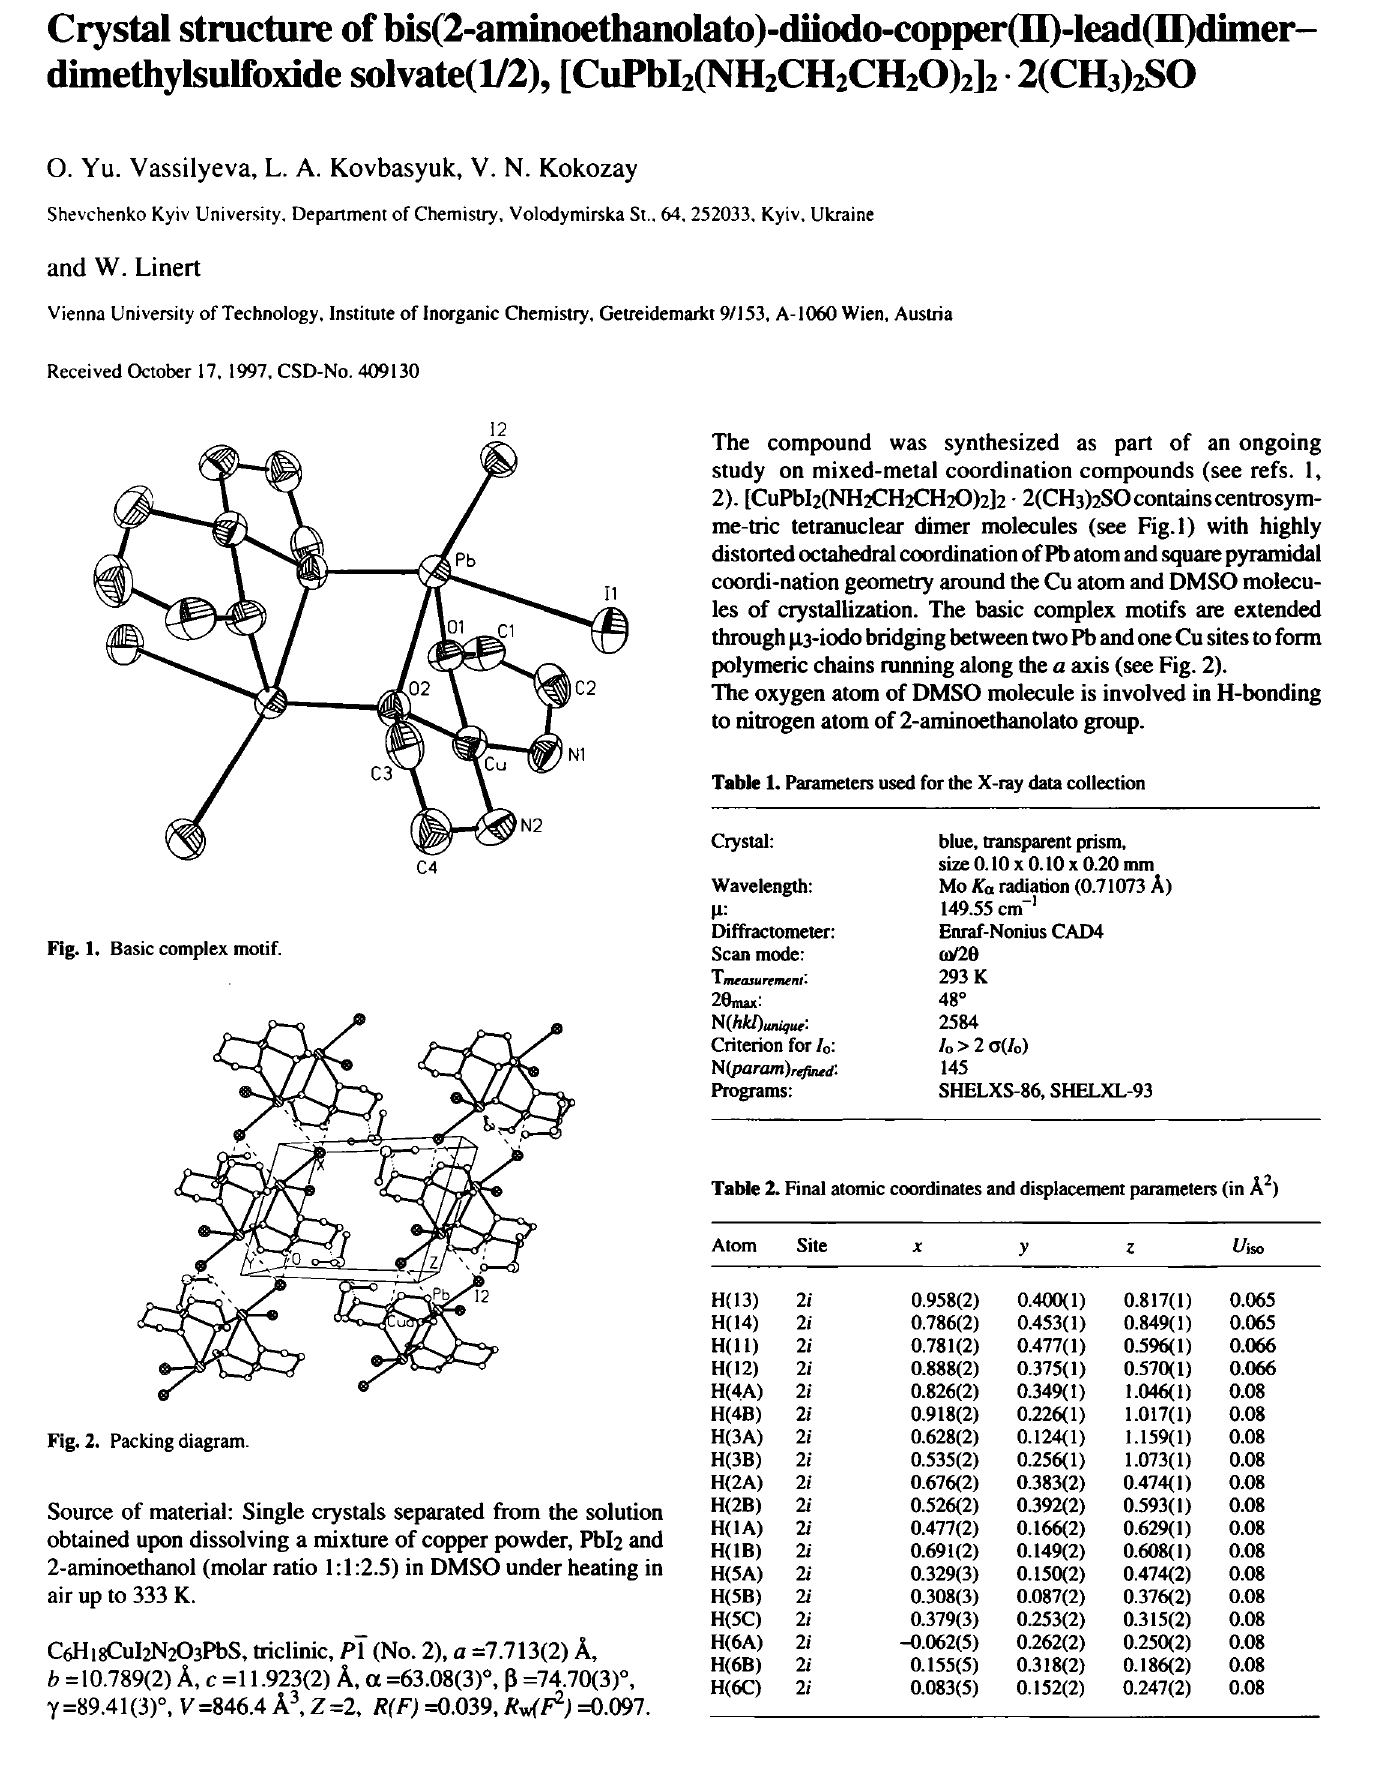
Fig. 2. Packing diagram. Source of material: Single crystals separated from the solution obtained upon dissolving a mixture of copper powder, Pbl2 and 2-aminoethanol (molar ratio 1:1:2.5) in DMSO under heating in air up to 333 K. C6Hi8Cul2N203PbS, triclinic, PI (No. 2), a =7.713(2) Â, b =10.789(2) Â, с =11.923(2) Â, α =63.08(3)°, β =74.70(3)°, γ =89.41(3)°, V =846.4 Â^ Ζ=2, R(F) =0.039, Rv^F^) =0.097.